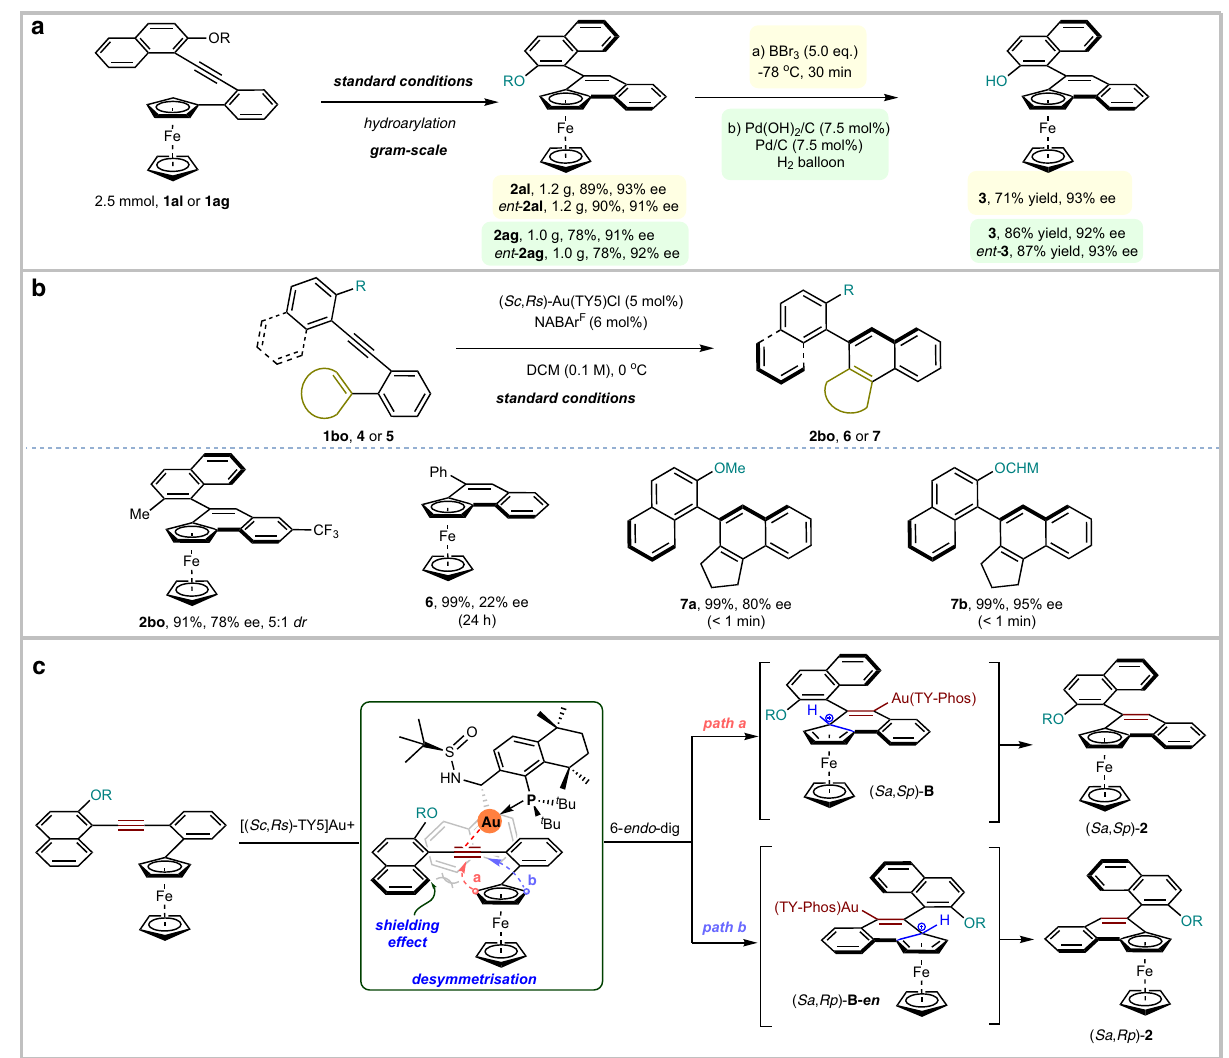
Fig. 4 Proof-of-principle study. a The practical utility. b mechanism study. c proposed asymmetric induction